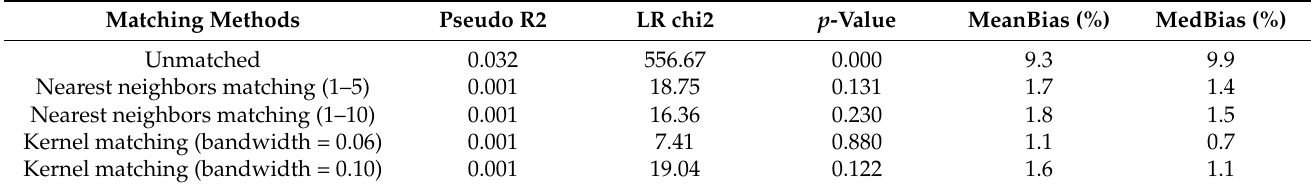
Table 10. Balancing test results for independent variables before and after matching (outcome variable: Malnutrition).